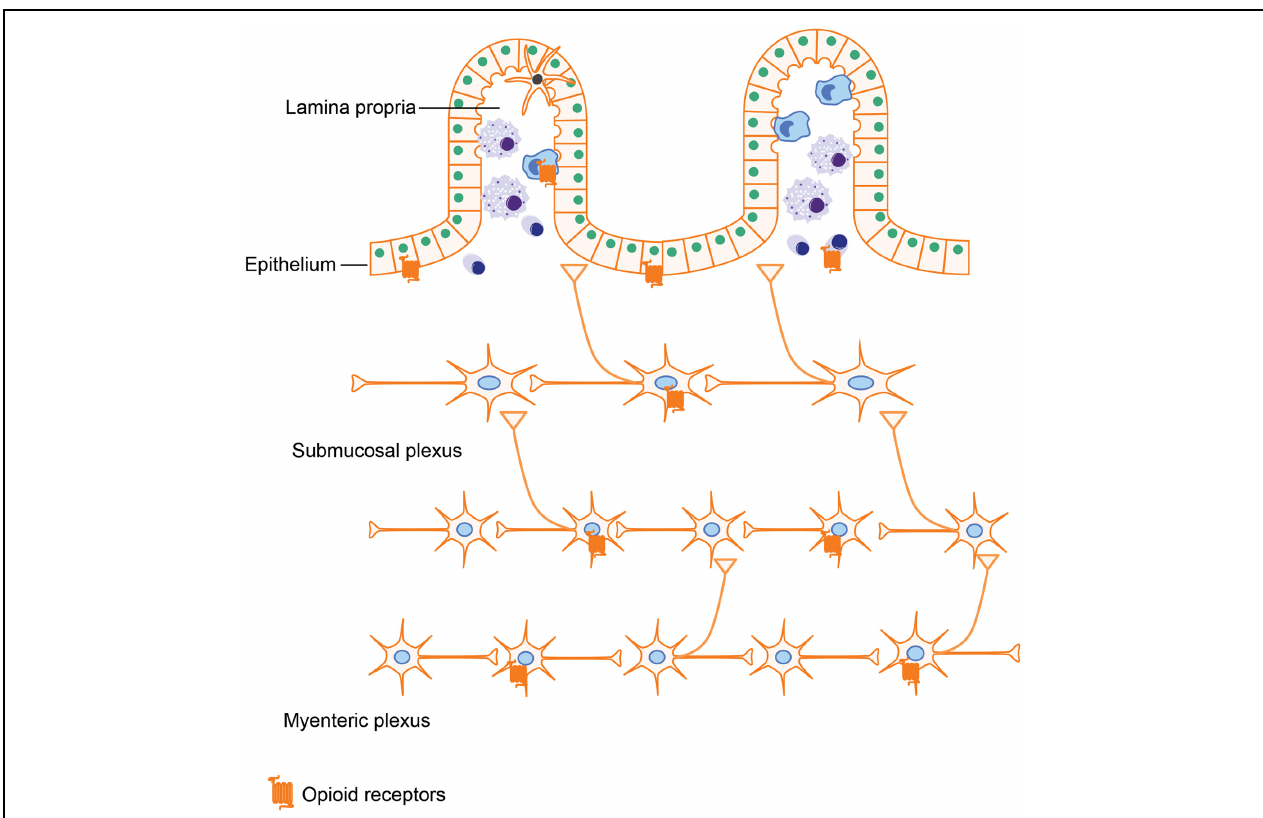
FIGURE 3 | Opioid receptor distribution in intestines. Opioid receptors are not only expressed on neutrons in the myenteric plexus and submucosal plexus, which are involved in modulating gut motility and secretion but are also expressed on intestinal epithelial cells and immune cells, implying that opioids could impact the gut barrier function and immune responses as